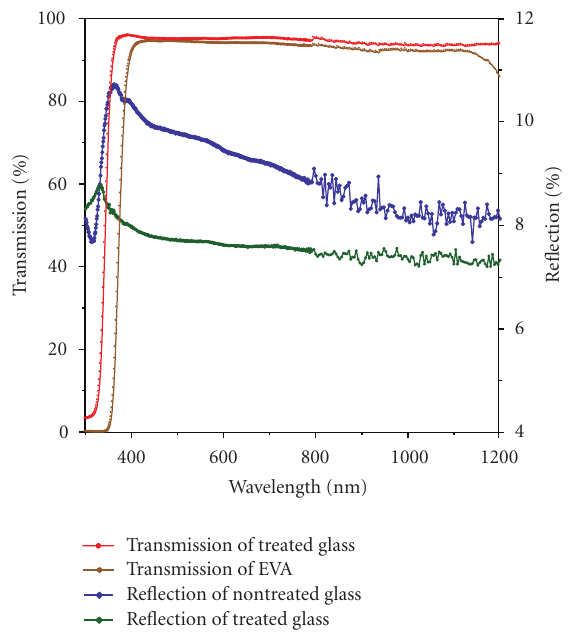
Figure 3: Optical transmission and reflection of the glass and the EVA used for the fabrication of the UDTS’s modules.